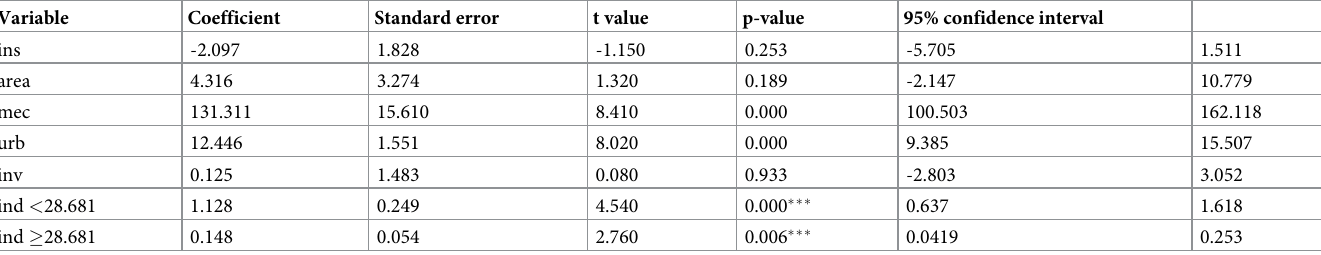
Table 9. Parameter estimation results of agricultural insurance density and farmer income threshold model.